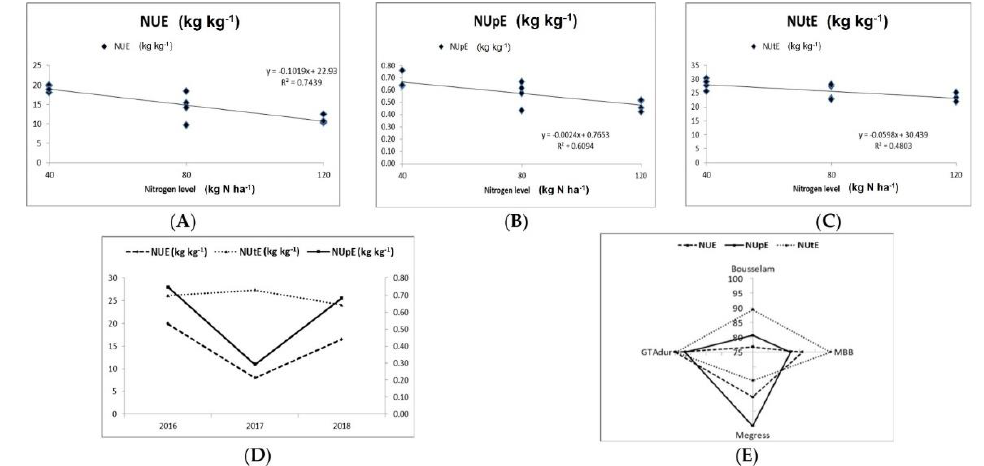
Figure 4. NUE ( A ) and its components NUpE ( B ) and NUtE ( C ), as affected by nitrogen level and by growing season ( D ) and the genotype performance for NUE and its components ( E ).